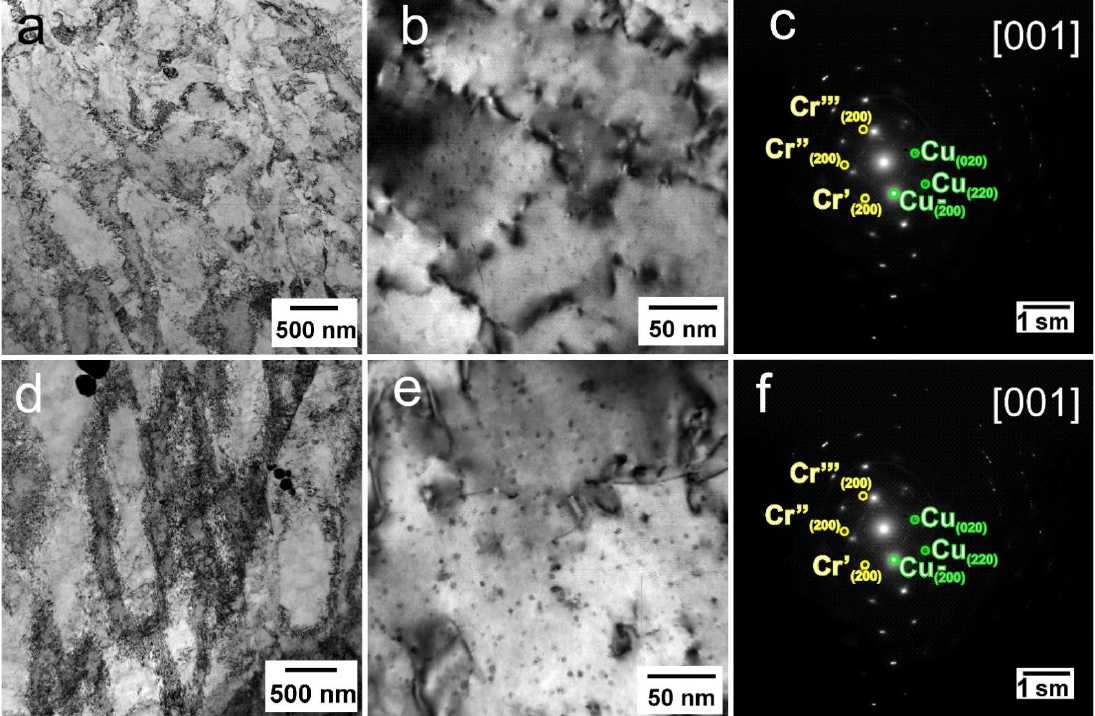
Figure 5. Microstructure of the Cu-0.5%Cr-0.08%Zr alloy after RS and subsequent aging: ( a , b ) ex- trusion + quenching + RS + aging at 500 °C for 2 h and ( c ) the diffraction pattern from the image obtained; ( d , e ) extrusion + RS + aging at 500 °C for 2 h and ( f ) the diffraction pattern from the image obtained.